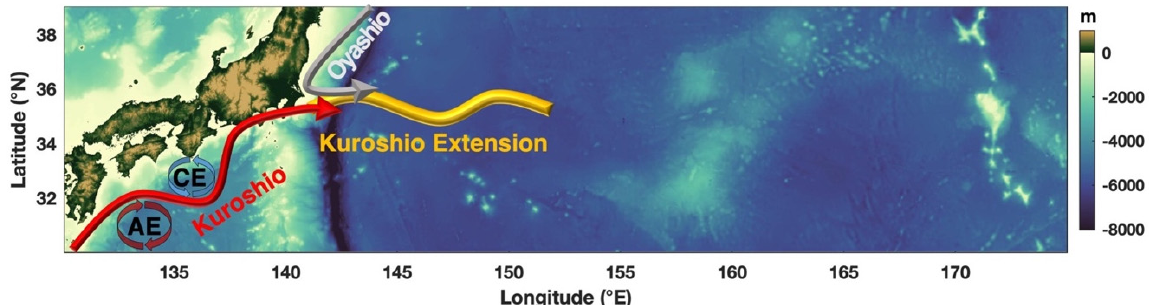
Figure 1. Topography (m), currents and major dynamic processes in the Kuroshio extension (KE) region. The major bathymetric features with shallow topography are the Izu-Ogasawara Ridge (139.7 ◦ E), the Shatsky Rise (159.8 ◦ E) and the Emperor Seamount (171.4 ◦ E). The schematic cyclonic (CE) and anticyclonic (AE) circulations that are frequently present to the south of Japan are labeled [1].